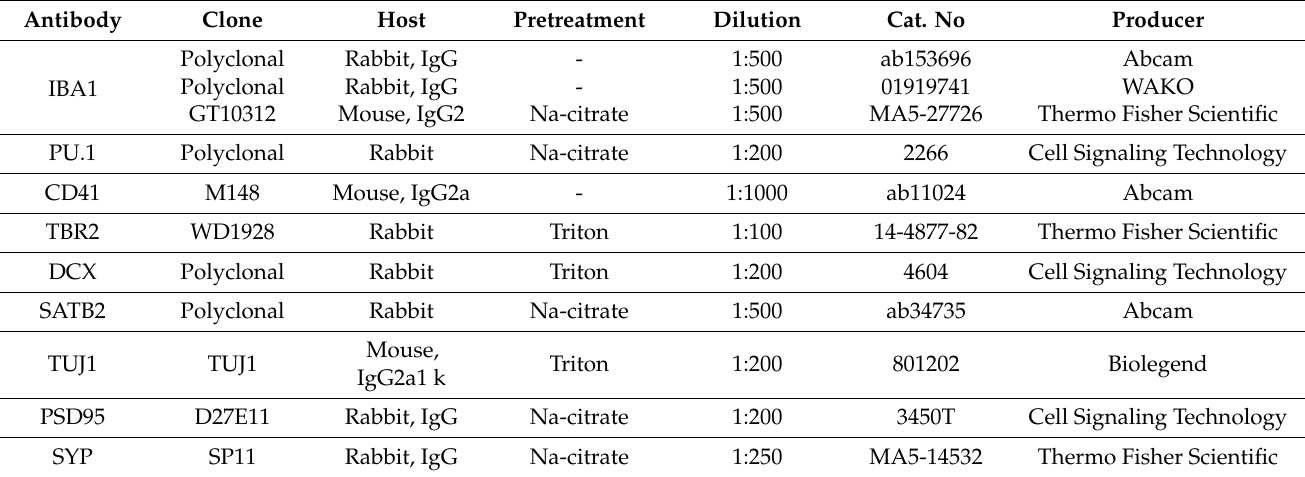
Table 4. Antibodies used in the organoid immunohistochemistry. Antibodies produced by Abcam (Cambridge, UK), WAKO (Fujifilm Wako Chemicals USA, Richmond, VA, USA), Cell Signaling Technology (Danvers, MA, USA) and Thermo Fisher